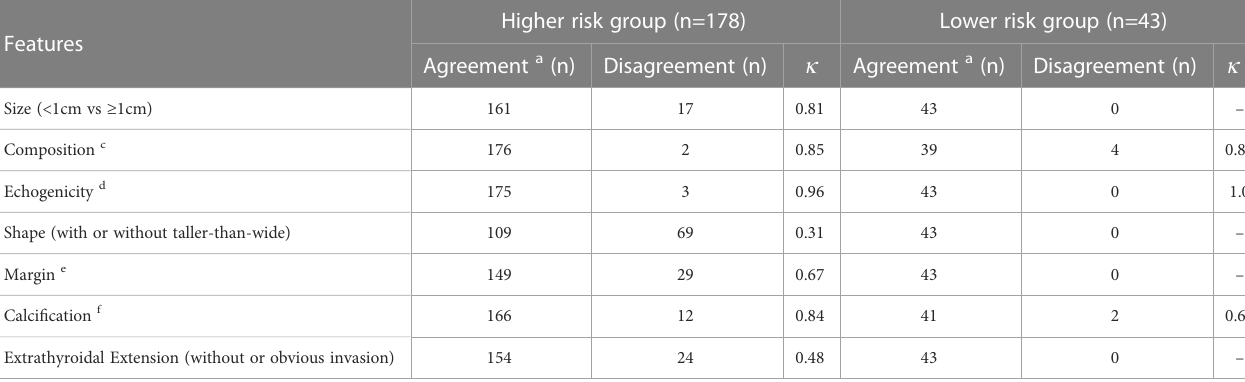
TABLE 3 Agreement of US characteristics in transverse and longitudinal